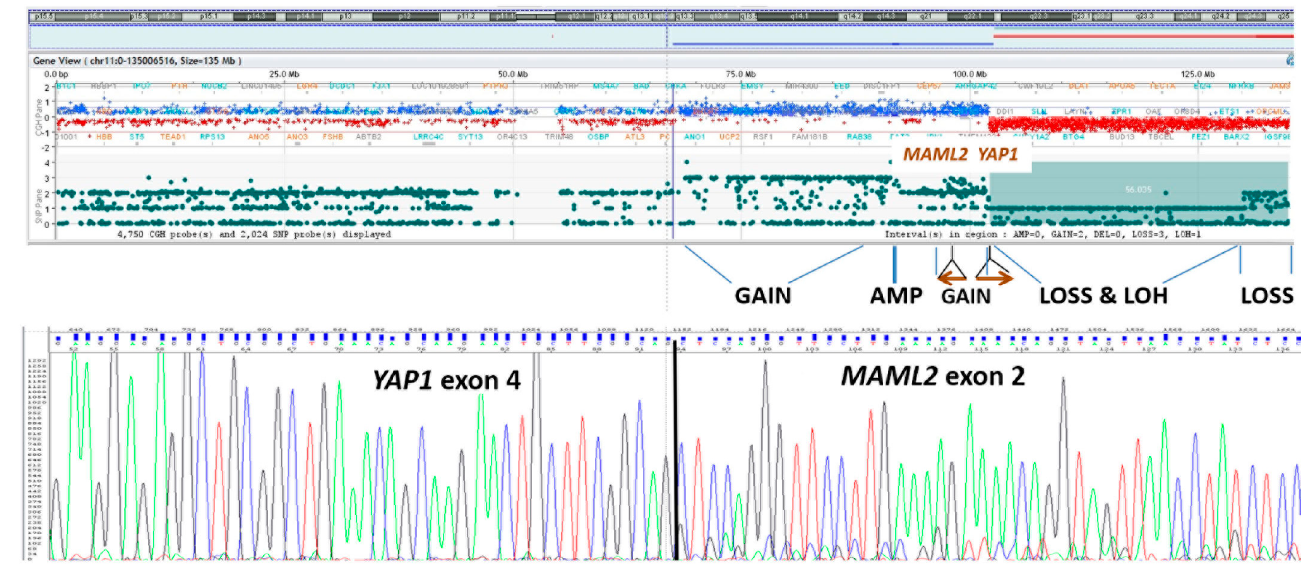
Figure 4. Array-CGH profile of chromosome 11, showing evidence of chromotrypsis with breakpoints located at YAP1 and MAML2 gene loci. Sanger sequencing electropherogram demonstrating the presence of YAP1 /MAML2 fusion transcript from tumor RNA.